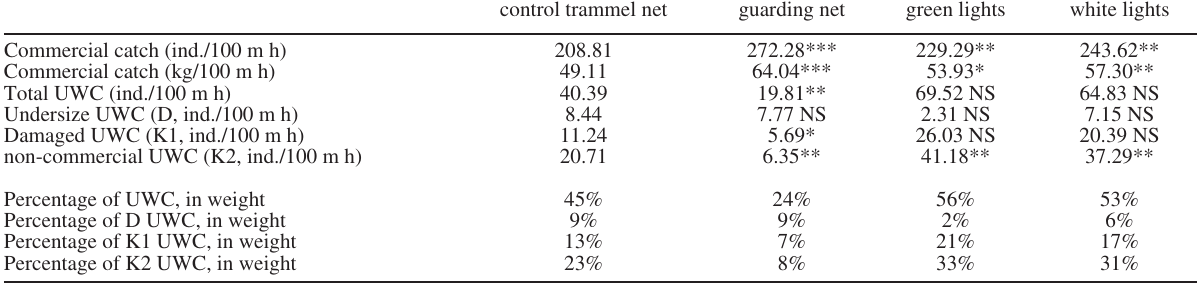
Table 4. – Summary results of the trammel net experiments. UWC, unwanted catches that would normally be discarded. Discarding reasons: (D) Undersize individuals falling under the Landings Obligation (Art. 15 of EU Reg. 1380/2013); (K1) damaged individuals of otherwise com- mercial species; (K2) non-commercial benthic invertebrates. Asterisks represent the significance level of the comparison (larger or smaller catches) between the modified net and the control net (NS, not significant, * p=0.05, ** p=0.01, *** p=0.001).